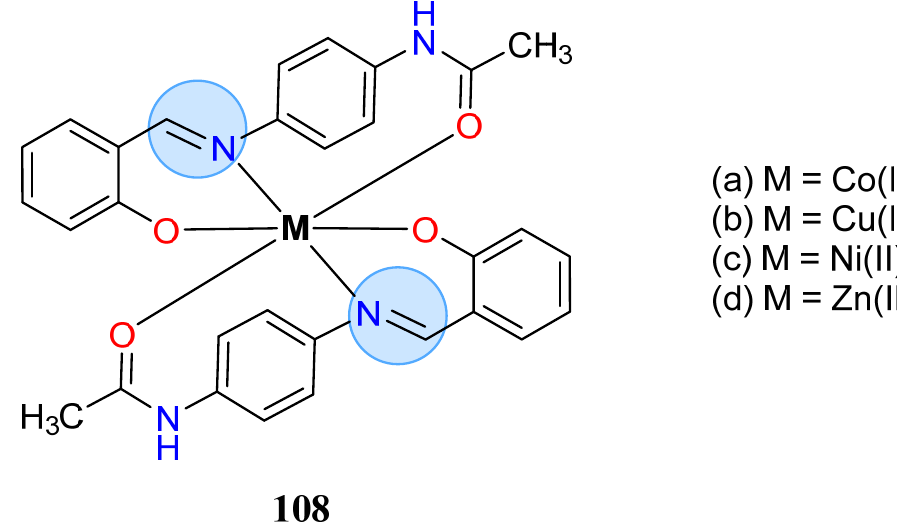
Figure 56. Transition metal(II) complexes with Schiff base derived from p -amino-acetanilide and salicylaldehyde studied for their antifungal activity.